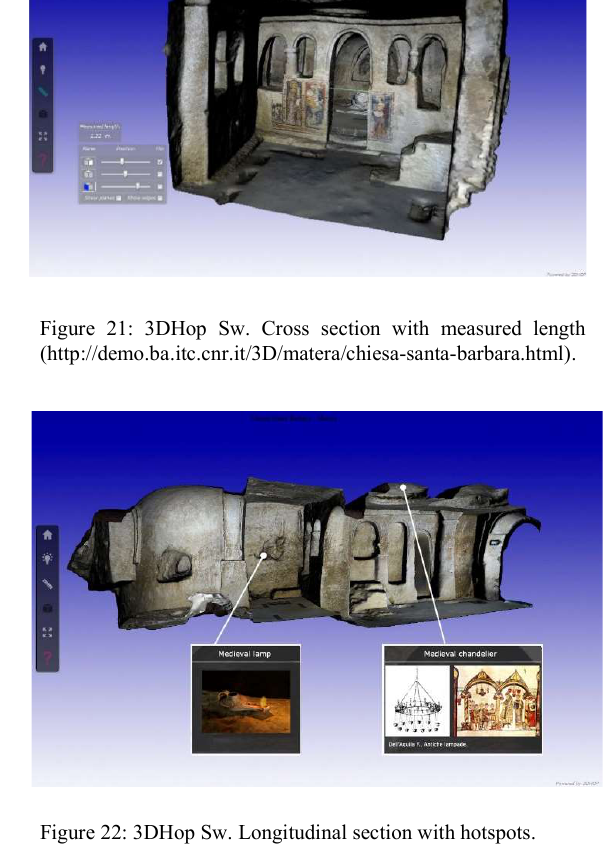
Figure 22: 3DHop Sw. Longitudinal section with